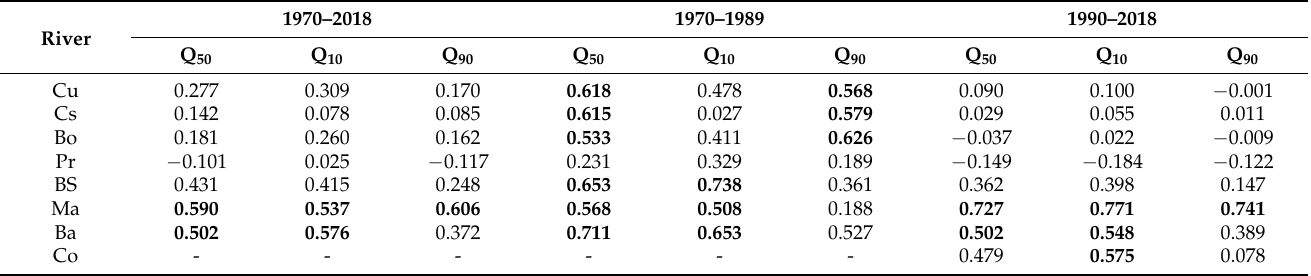
Table A1. Adjusted R 2 of the second-order MR models predicted by Niño 3.4 and DMI in SON a set in three different periods. The values higher than 0.5 are bolded, indicating good model skill.